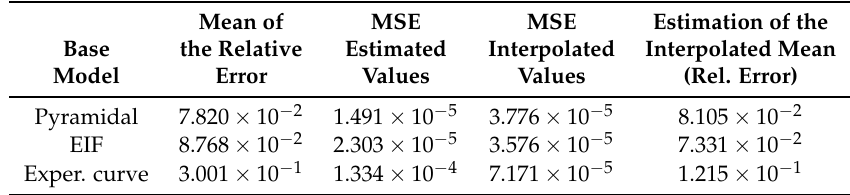
Table 5. Errors caused by the computation of the T − g syn curve. Data have been generated using the pyramidal cell model with noise (mean 0 and σ V = 0.1). The synaptic drive is governed by a synaptic conductance trace extracted from an in silico network (see end of Section 2.1.2) where we have added noise with mean 0 and σ = 0.0001 (see Figure 4a, black